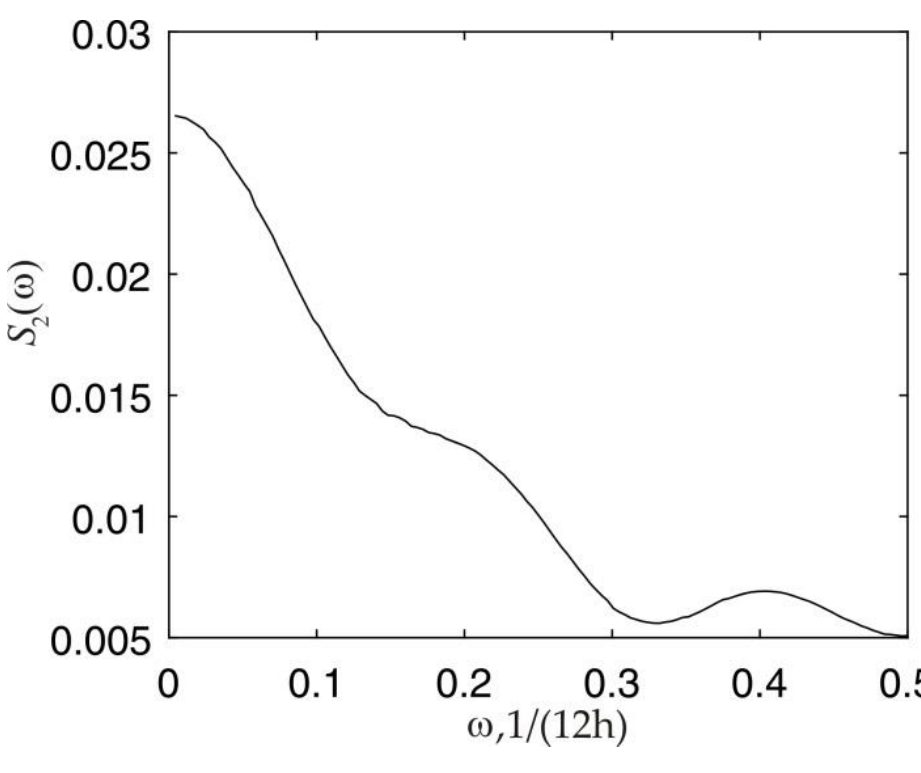
Figure 6. Sample spectrum of the process e t, 2 .